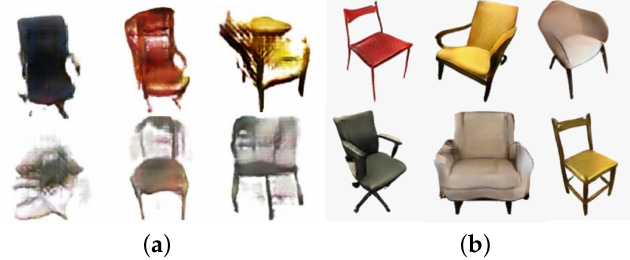
Figure 5. Result of WGAN; ( a ) poor performance; ( b ) good performance.